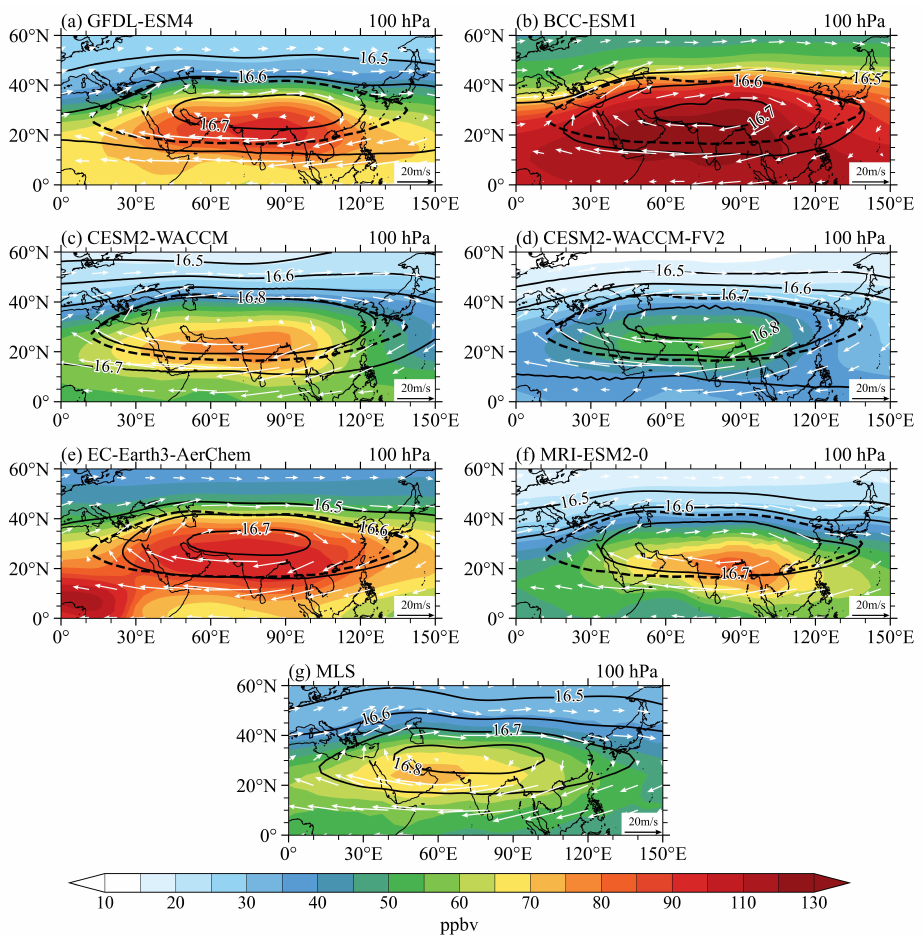
Figure 1. Climatology of CO mixing ratio (color shaded, ppbv) at 100 hPa for the simulations of six CMIP6 models and MLS observations during JJA 2005–2014. Black contours represent the geopotential height (GPH) from each model ( a – f ) and NCEP data ( g ). The white vectors indicate wind fields from models ( a – f ) and NCEP data ( g ). The black dashed contour in ( a – f ) is the 16.7 gpm contour of GPH from NCEP